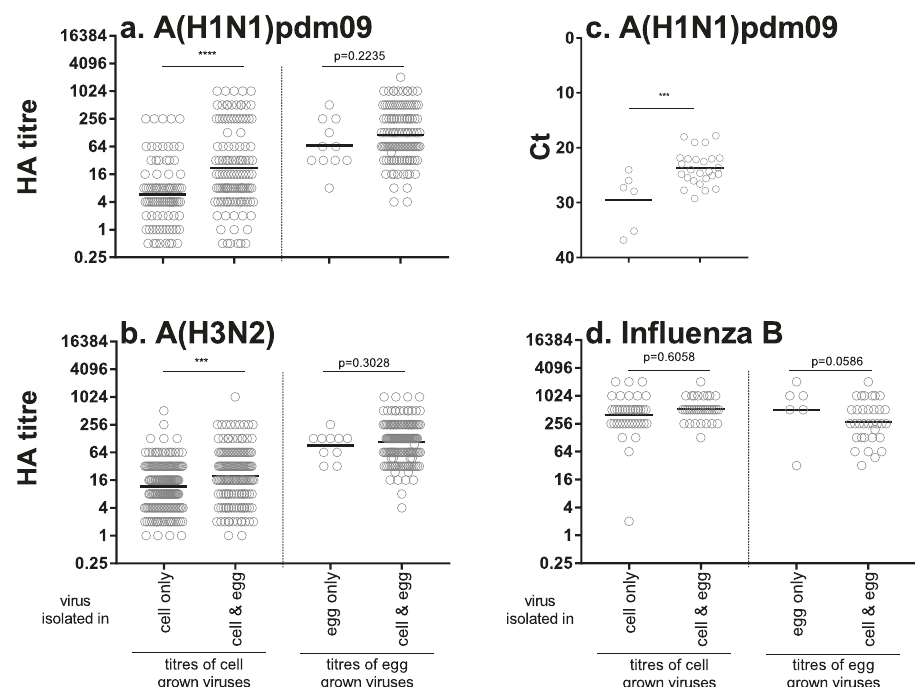
Fig. 5 Assessment of HA titre for cell-grown or egg-grown viruses. Viruses were inoculated into both cells and eggs and growth was assessed, as per Fig. 1a. Cell-grown viruses were grouped by viruses that were isolated only in cells as compared to viruses that were isolated in cells and eggs. Egg-grown viruses were grouped by viruses that were isolated only in eggs as compared to viruses that were isolated in cells and eggs. The HA titres were plotted for A(H1N1)pdm09 ( a ) and in fl uenza B ( d ) as detected by turkey RBC and A(H3N2) ( b ) as detected by GP RBC. c The Ct of vRNA for a subset of A(H1N1)pdm09 samples was measured. *** p < 0.001, **** p < 0.0001. The difference in HA titres or Ct was assessed using an unpaired t